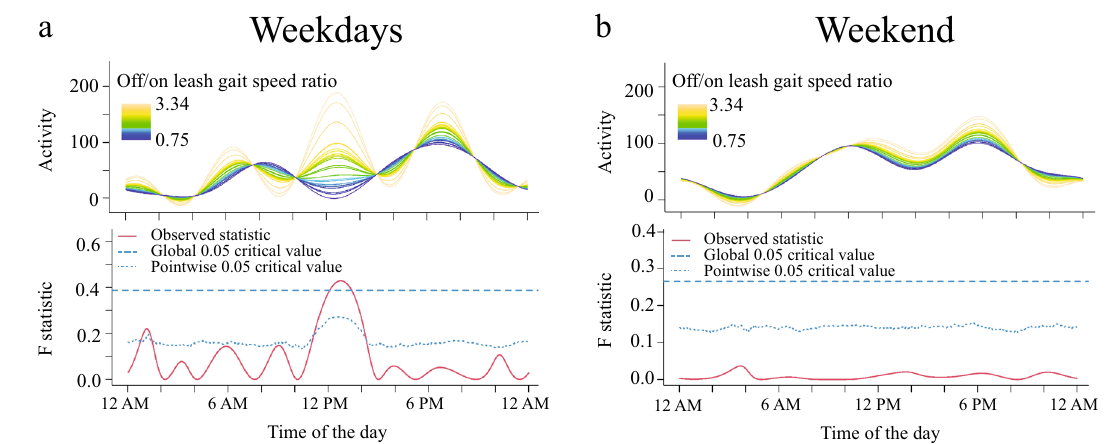
Figure 5. Relationship between off leash to on leash gait speed and activity levels in senior dogs during weekdays ( a ) and weekend ( b ). The upper graph illustrates activity over time for different levels of the variables analyzed and the lower graph indicates the level of significance of the differences. When the observed statistic (red line) is above the test of significance set at 0.05 (blue lines) it indicates significant differences between different levels of the variable. The dashed and the dotted lines indicate global and point-wise test of significance respectively. Dogs with higher levels of food-motivation were more active between 10.30 to 2.15 PM on